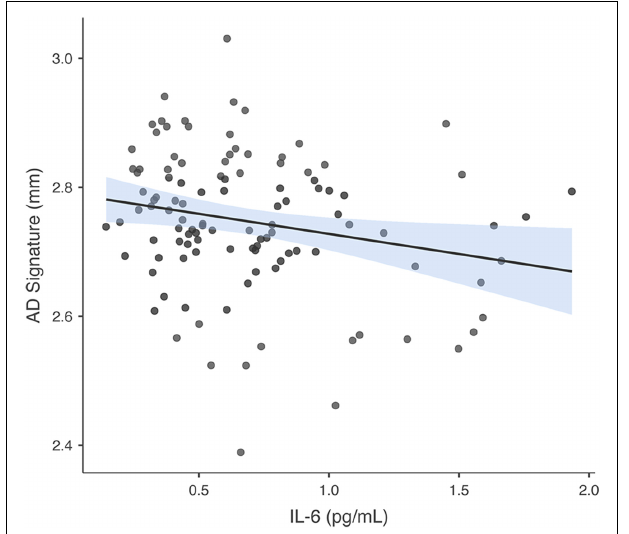
FIGURE 2 | Association between AD signature and IL-6. Scatterplot depicting the raw association between the AD Signature mean cortical thickness and IL-6.